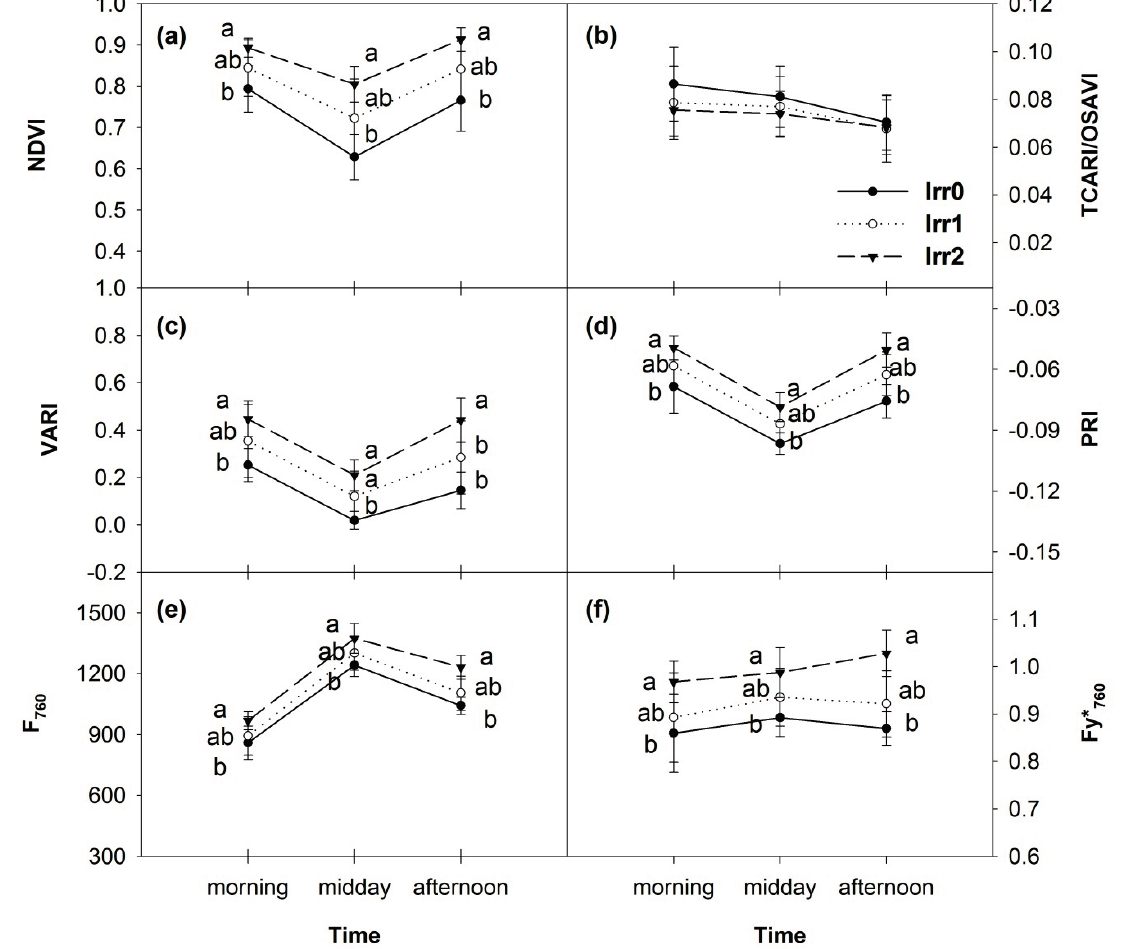
Figure 8. Time courses of NDVI ( a ); TCARI/OSAVI ( b ); VARI ( c ); PRI ( d ); F 760 ( e ) and Fy * 760 ( f ) for the three water treatments. Vertical bars are ± one standard deviation. Vegetation indices and fluorescence were analyzed with the non-parametric Kruskal–Wallis test. The results of the test are evidenced by letters on the plots. Statistically different (p < 0.05) means are designated with different